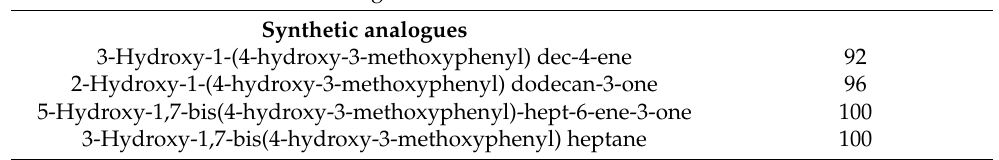
Table 8. Inhibitory effects of phenolic compounds of Z. officinale on whole blood aggregation [146]. Isolated